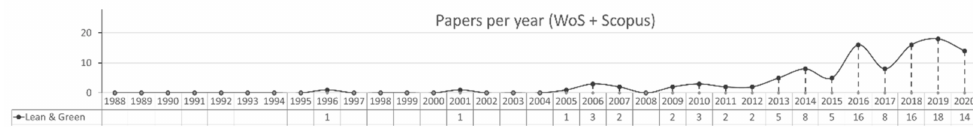
Figure 11. Lean and green evolution.